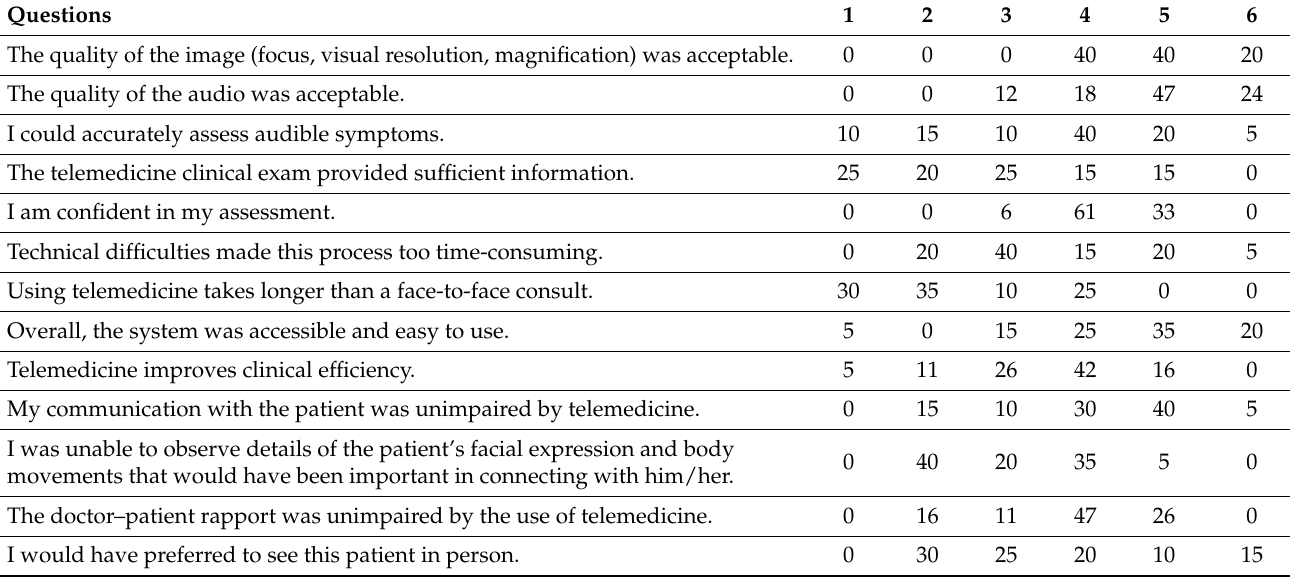
Table 3. Physicians’ responses to the survey described in